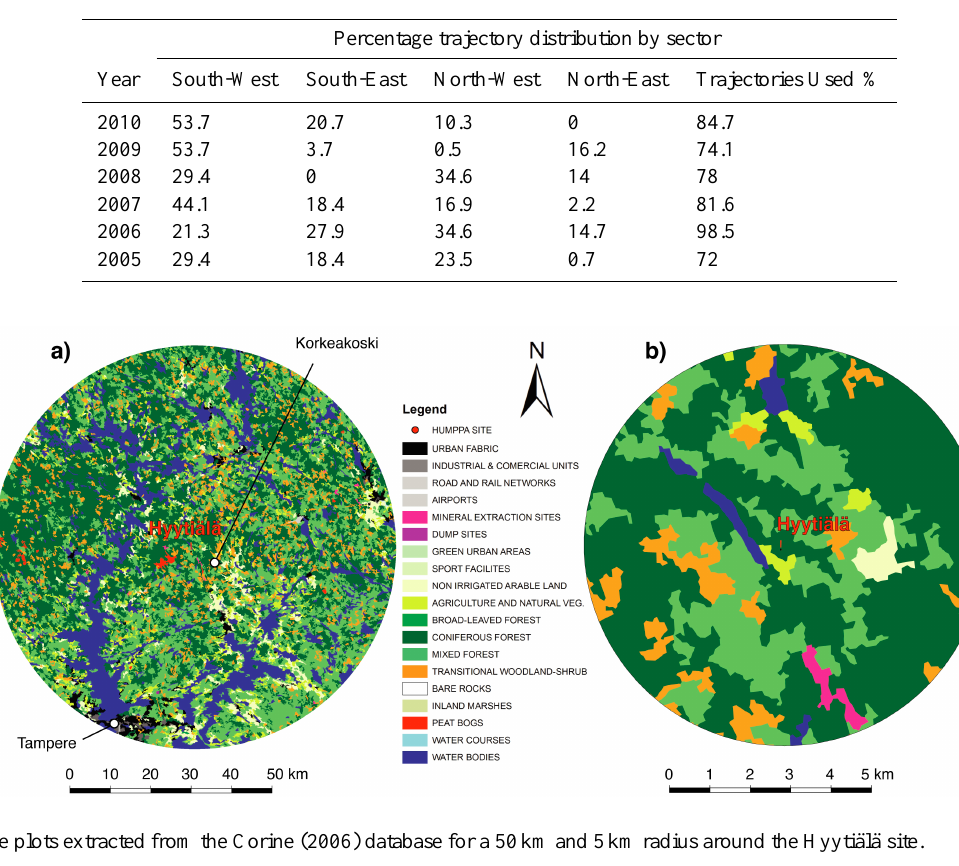
Fig. 5. Land use plots extracted from the Corine (2006) database for a 50km and 5km radius around the Hyyti¨al¨a